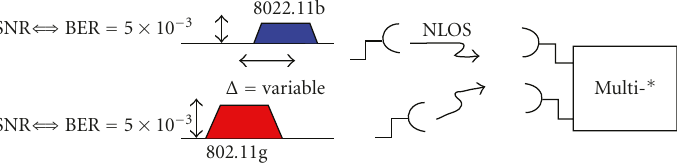
Figure 14: Definition of study case with overlapping channels.